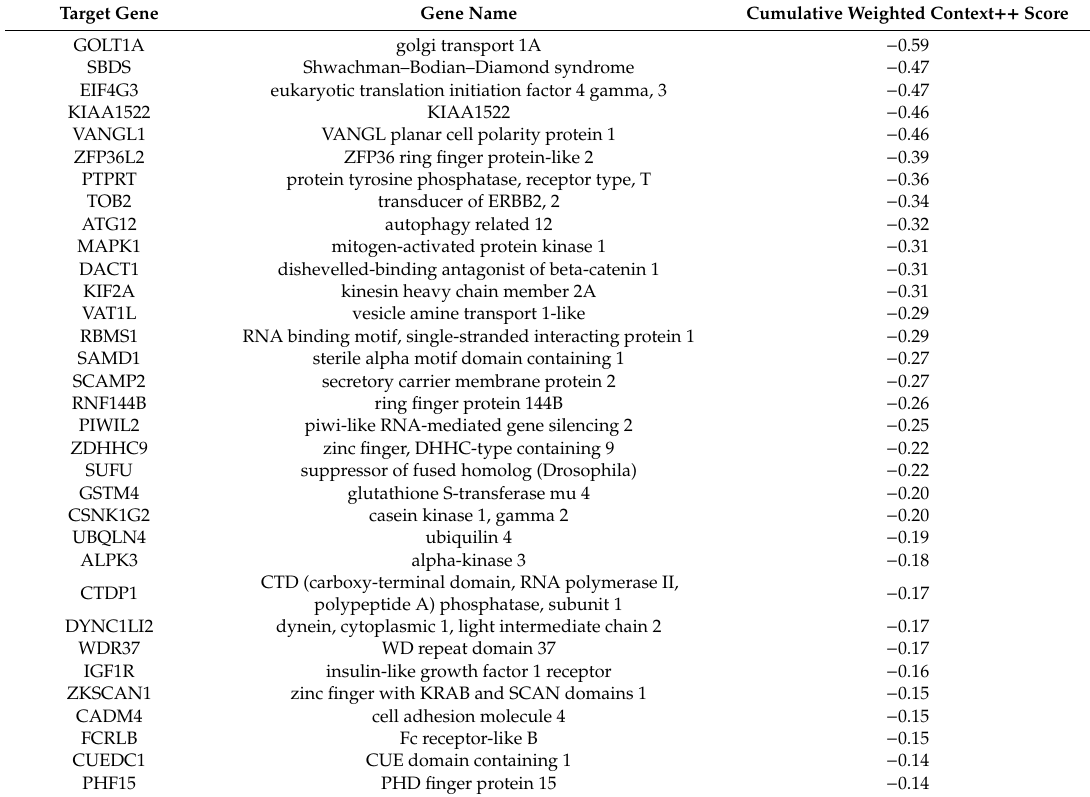
Table 6. List of predicted microRNA 378b target gene.